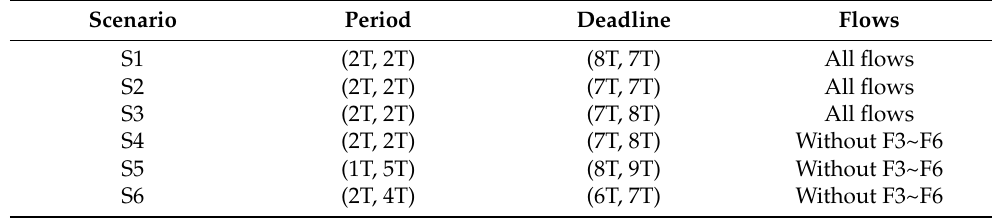
Table 8. Flows in network